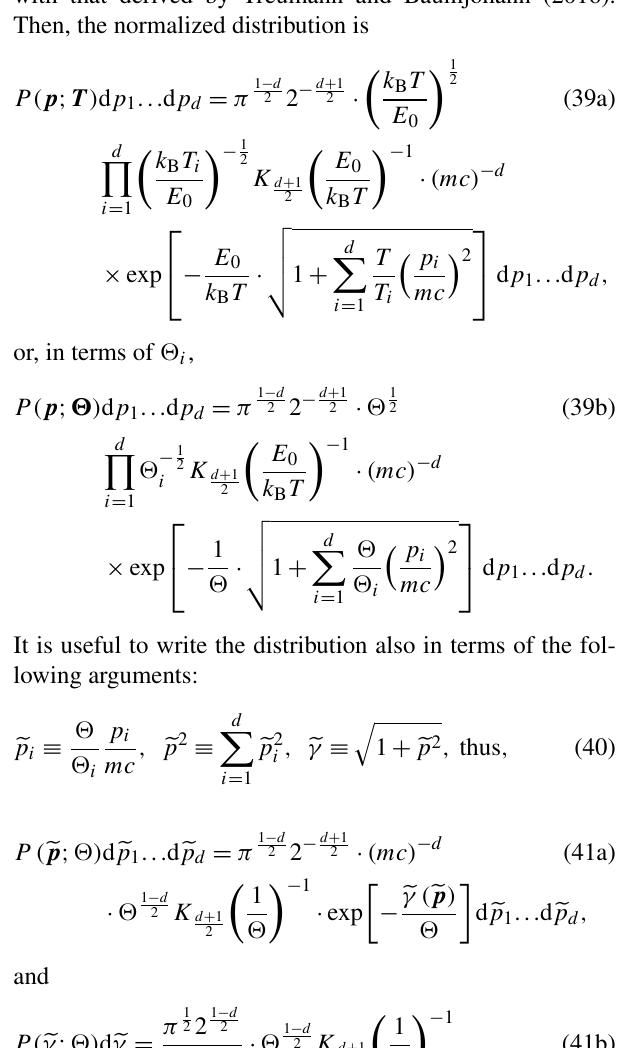
which is the anisotropic distribution, ure 3 shows the cases of anisotropic/isotropic MJ and MB